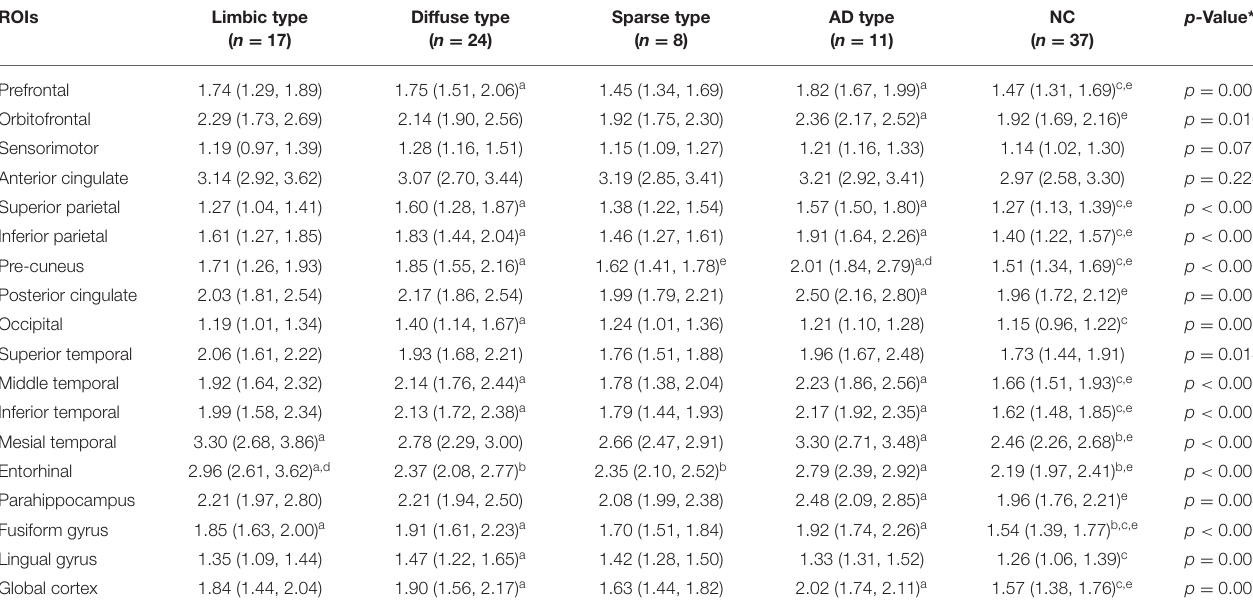
TABLE 1 | Regional SUVR values from [ 18 F] THK5351 PET scans of MCI patient subtypes and controls.